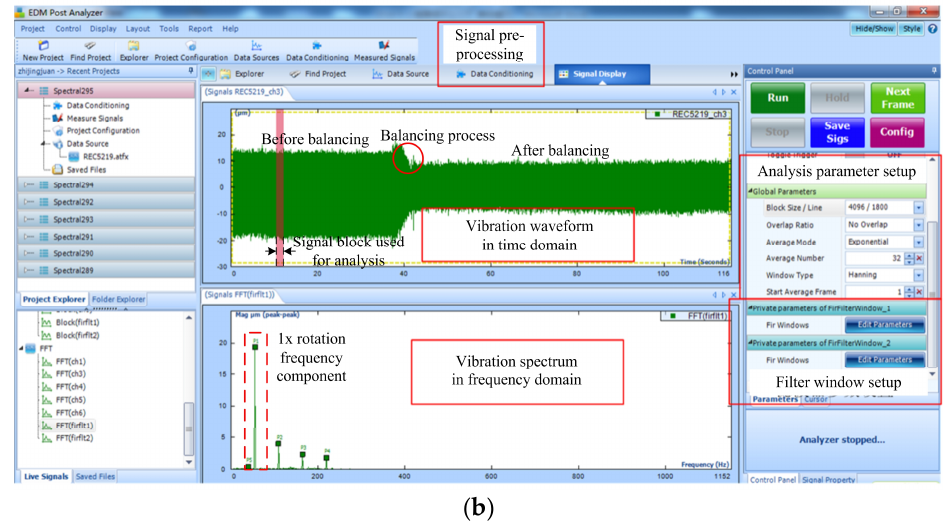
Figure 5. Vibration test and analysis flow chart for balancing purpose: ( a ) the whole test scheme; ( b ) vibration signal analysis scheme.